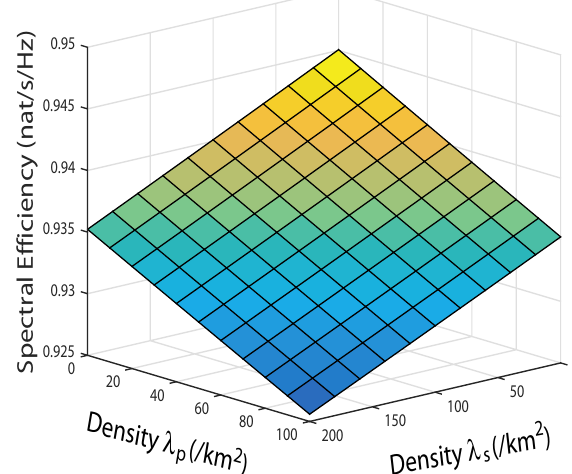
Figure 3. Spectral Efficiency vs. λ P s = 50 dBm and P p = 60